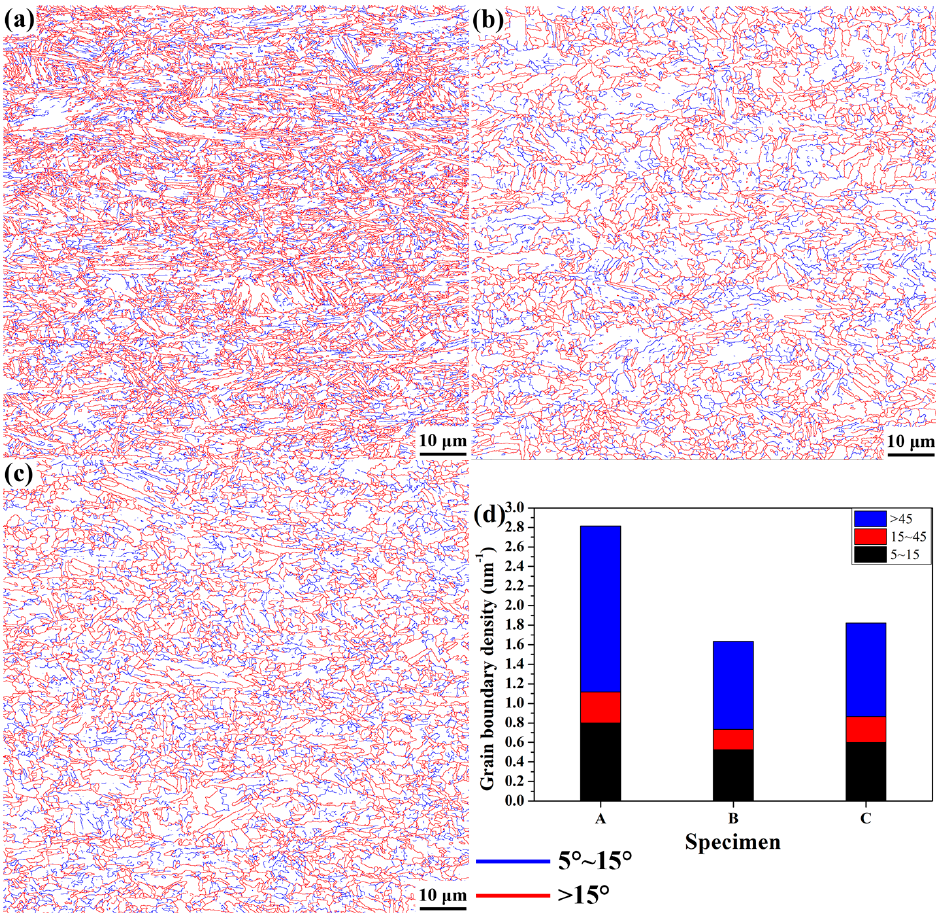
Figure 5. The distribution of grain boundaries ( θ > 5°) of specimen A ( a ), specimen B ( b ), specimen C ( c ), and the absolute density of boundaries ( d ).